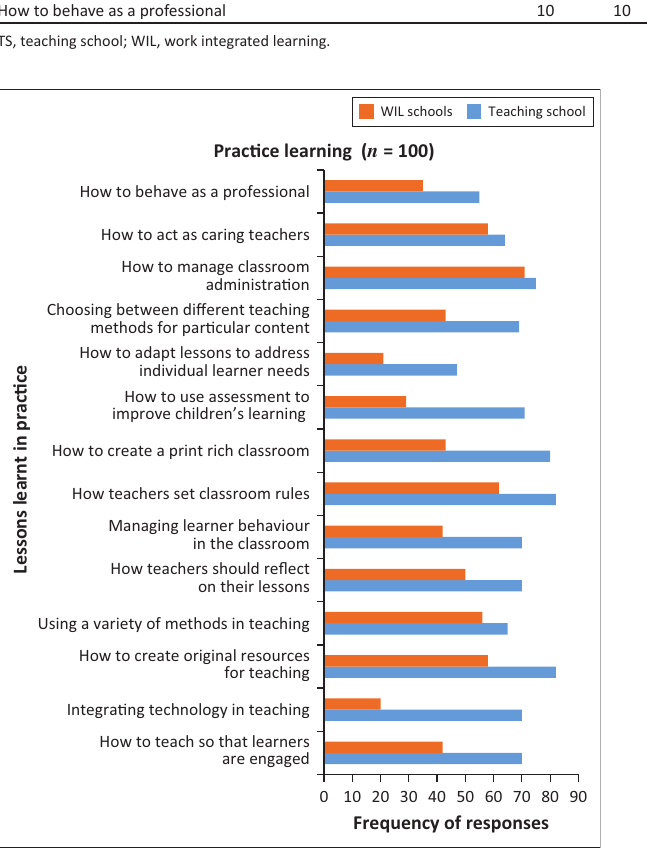
FIGURE 1: A comparison between the frequency of responses of outside schools versus the teaching school, including the quite a bit/quite a lot and very much responses only.